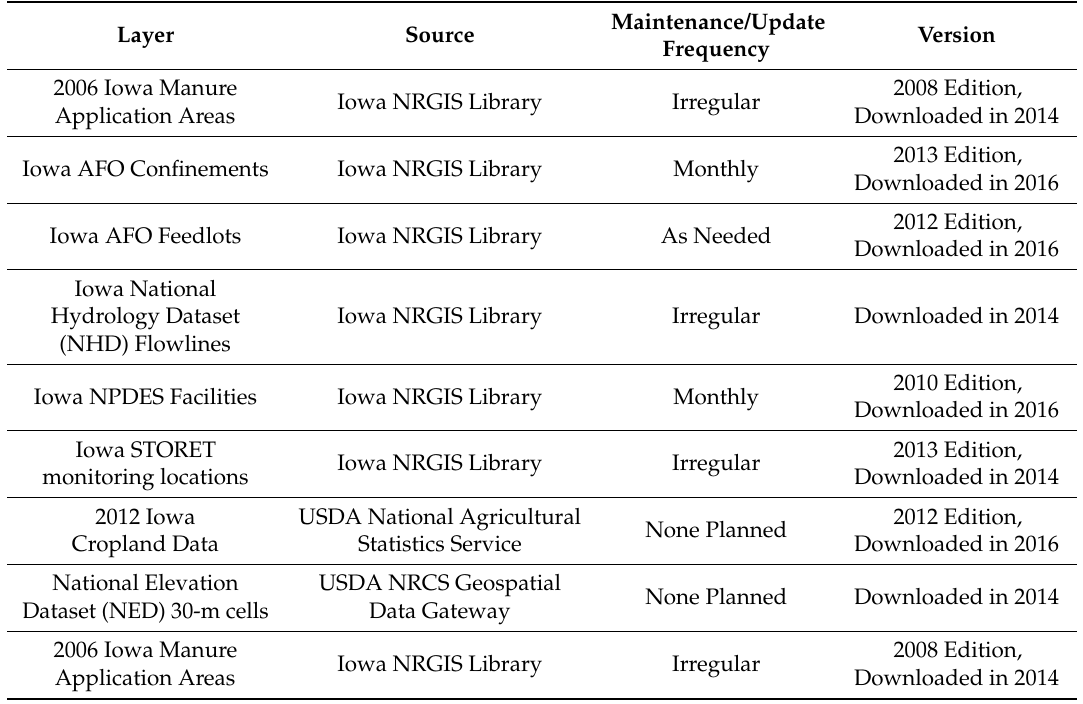
Table 1. GIS layers used for watershed delineation and statistical